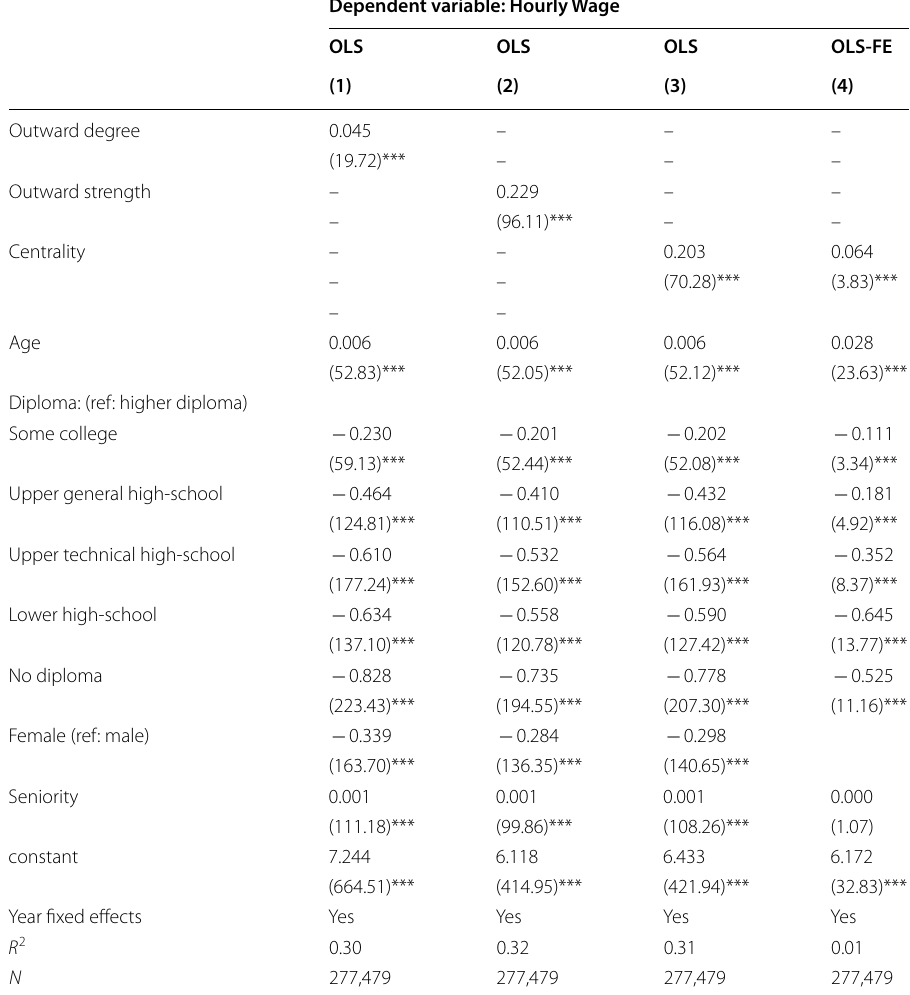
Table 4 Correlation between occupation centrality and wage